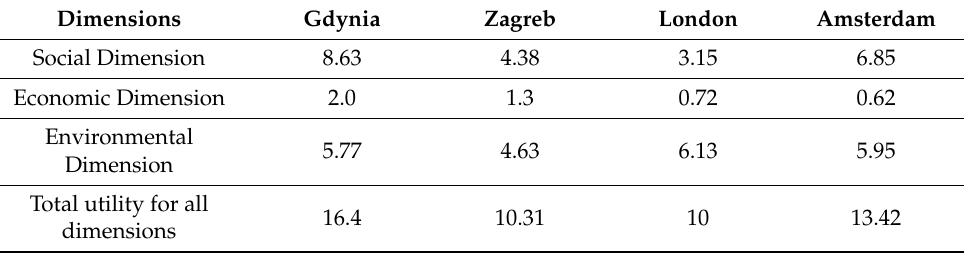
Table 5. Comparison of total utility by dimensions for the analyzed European